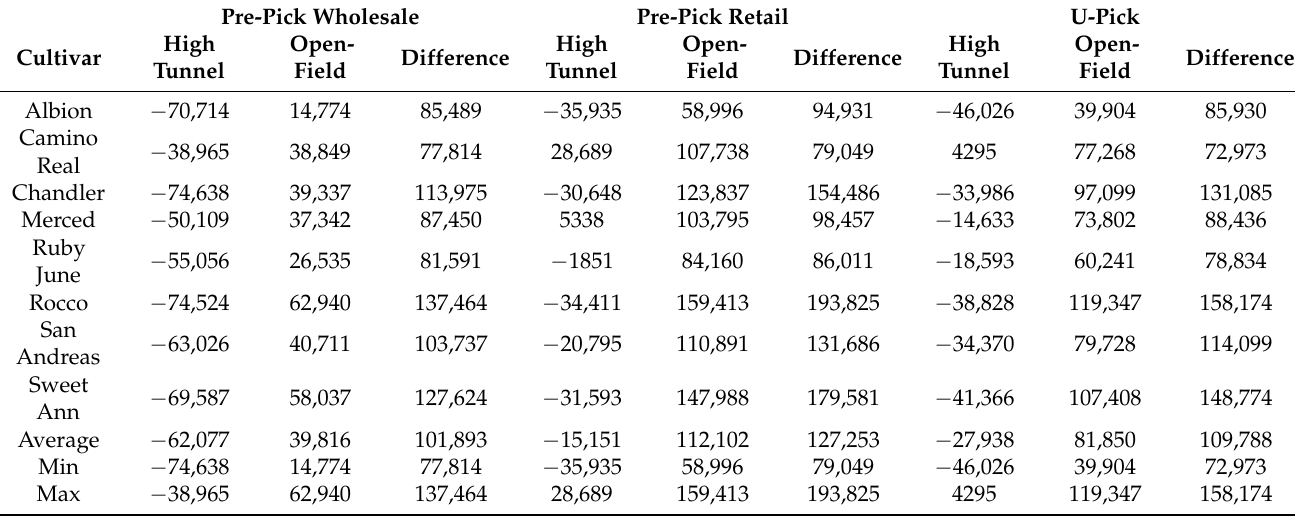
Table A3. Strawberry net revenues in USD per hectare (gross revenues—production costs) by cultivar and marketing strategy in the high tunnel and open-field